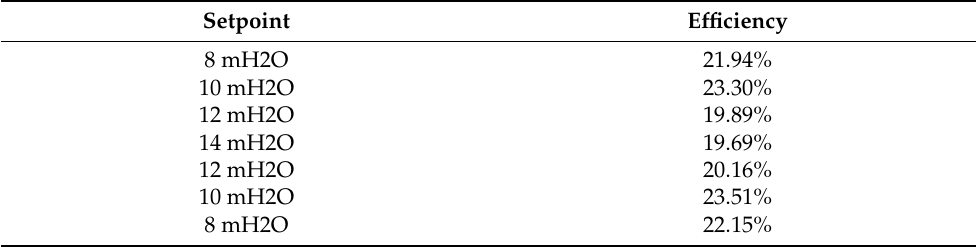
Table 6. Energy efficiency of the system operating with two pumps in series for different setpoints.